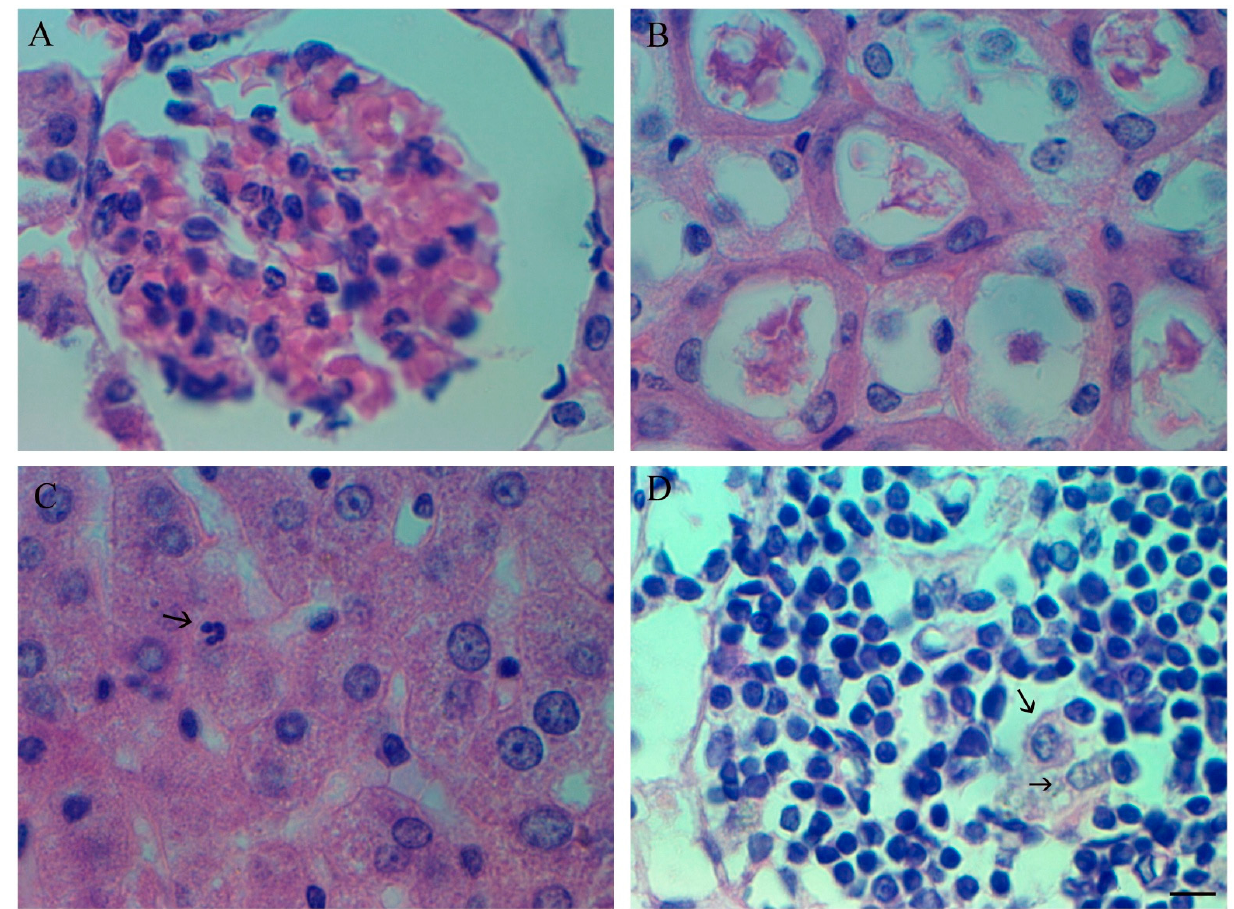
Figure 10. Inner organs pathology after infection by SARS-CoV-2 (Delta strain). ( A ) Hyperemia of glomeruli (5th dpi) HE staining; scale bar 10 µ m. ( B ) Hyaline masses visible in the proximal canals (5th dpi) HE staining; scale bar 10 μ m. ( C ) Light neutrophilic diapedesis in liver (5th dpi) HE staining; scale bar 10 μ m. ( D ) Increased number of resident macrophages in lymph nodes increases (7th dpi) HE staining; scale bar 10 μ m for ( A – D )